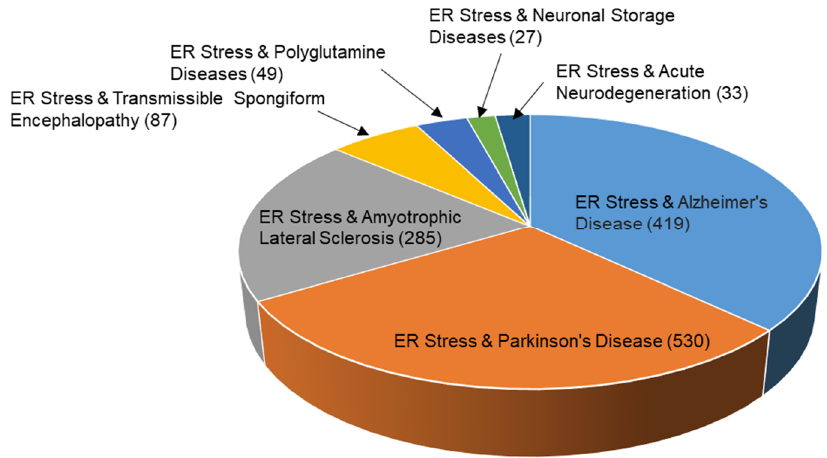
Figure 2. The number of articles related to neurodegenerative diseases and ER stress investigated by PubMed by 23 November 2022.